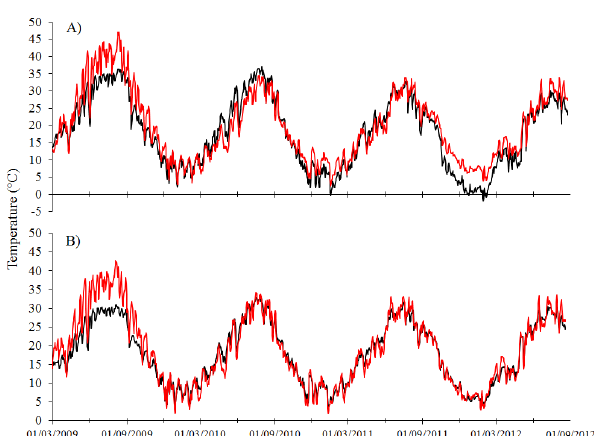
Figure 4: Observed and simulated soil temperature from March 2009 until September 2012. A) Site-1; B) Site-2; Black line are measured values, and red line are simulated values.